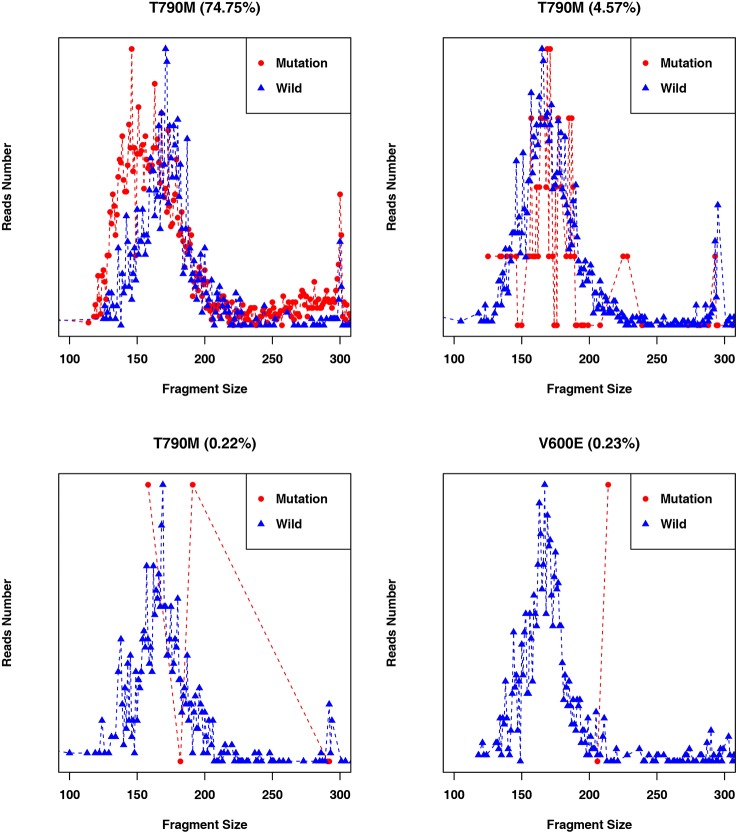
Fragment length distributions of cancer patient ctDNAs and normal cfDNAs with high, medium, or low EGFR-T790M mutant allele frequencies.